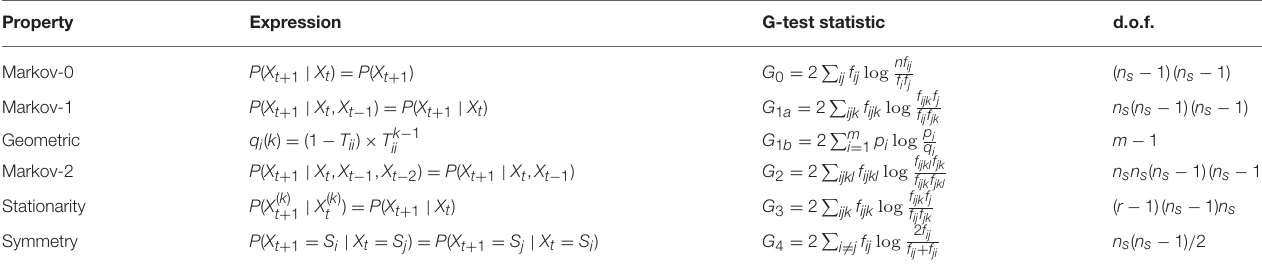
TABLE 1 | Test statistics for microstate